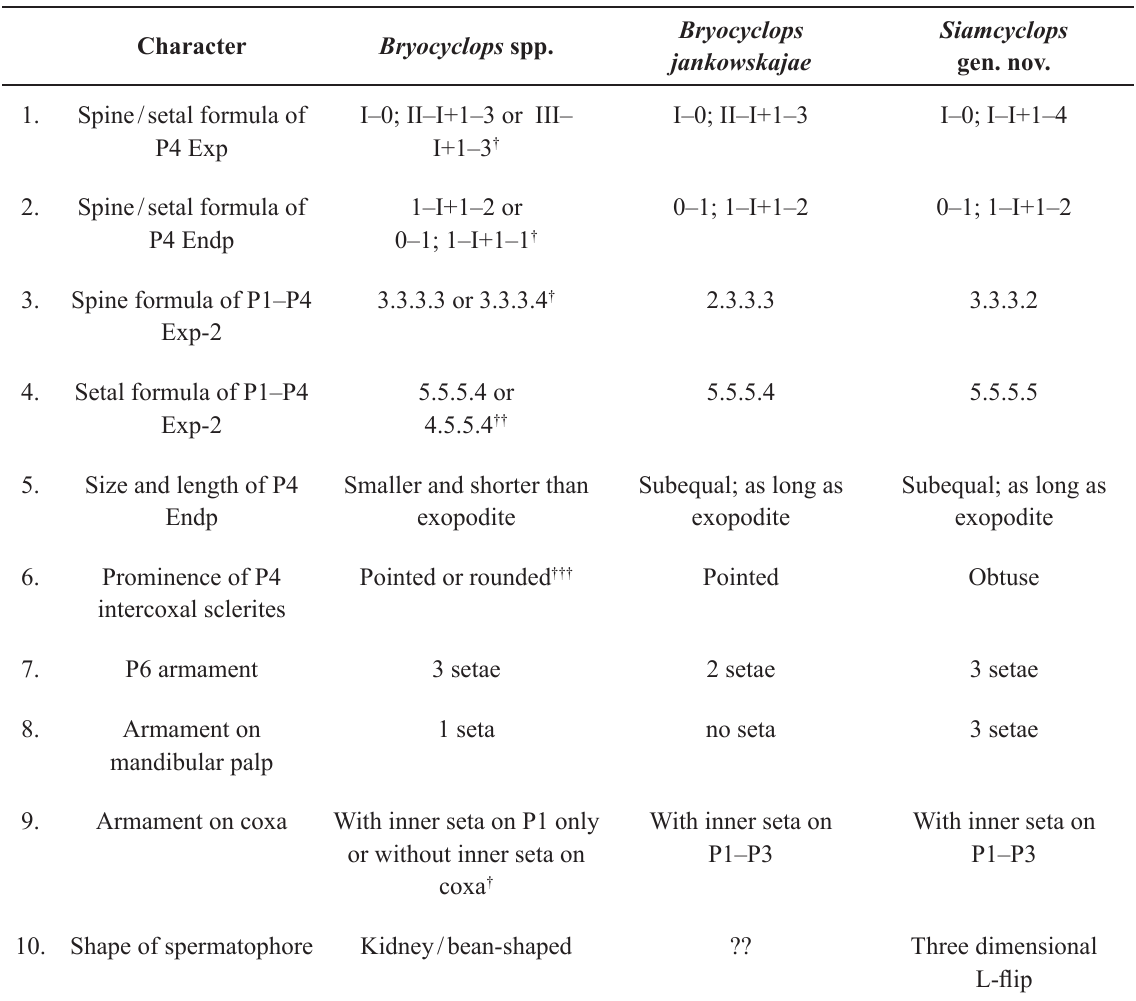
Table 1. Differential diagnosis between the genus Bryocyclops * Kiefer, 1927, Bryocyclops jankowskajae Monchenko, 1972 and Siamcyclops gen. nov. (Roman numbers = spine; Arabic numbers = seta). * only members of groups I and II (according to Lindberg 1947) are included; details on other groups of spine/seta formulae are in the